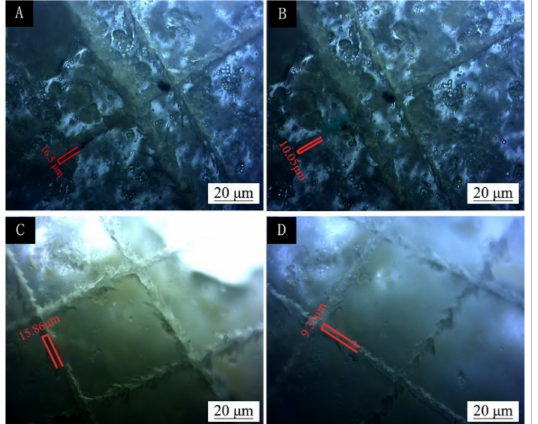
Figure 12. The OM of waterborne primer film with different concentration of microcapsules (600 rpm stirring rate) before and after repair: ( A ) and ( B ) before and after the repair of 5.0% microcapsules, ( C ) and ( D ) before and after the repair of 10.0%